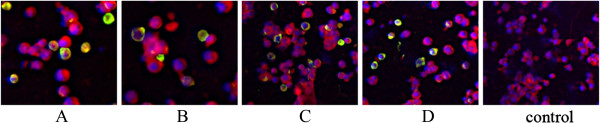
Representative IFA for detection of anti-S antibodies of non-SARS HCoVs in human serum. A, 229E-S expression plasmid; B, OC43-S expression plasmid; C, HKU1-S expression plasmid; D, NL63-S expression plasmid; control, mock plasmid pVRC-8304.